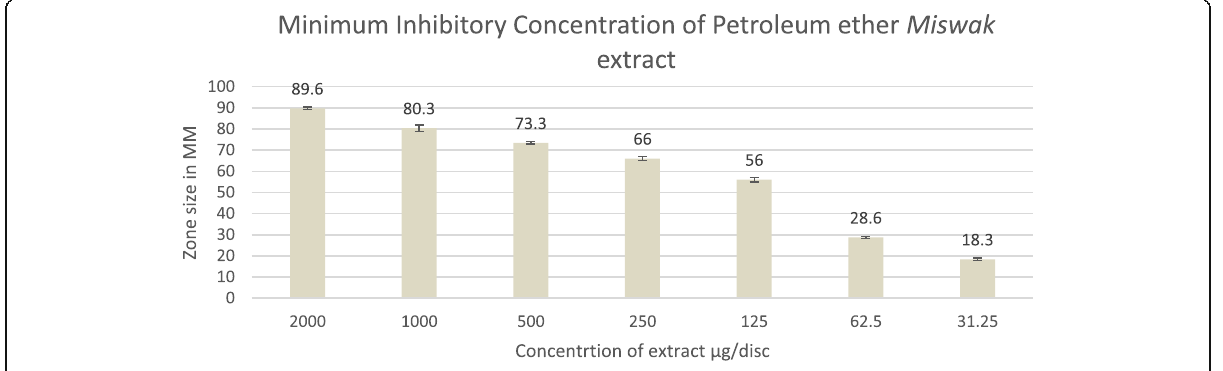
Fig. 2 Minimum inhibitory concentration of Miswak extracted in petroleum ether against C. albicans